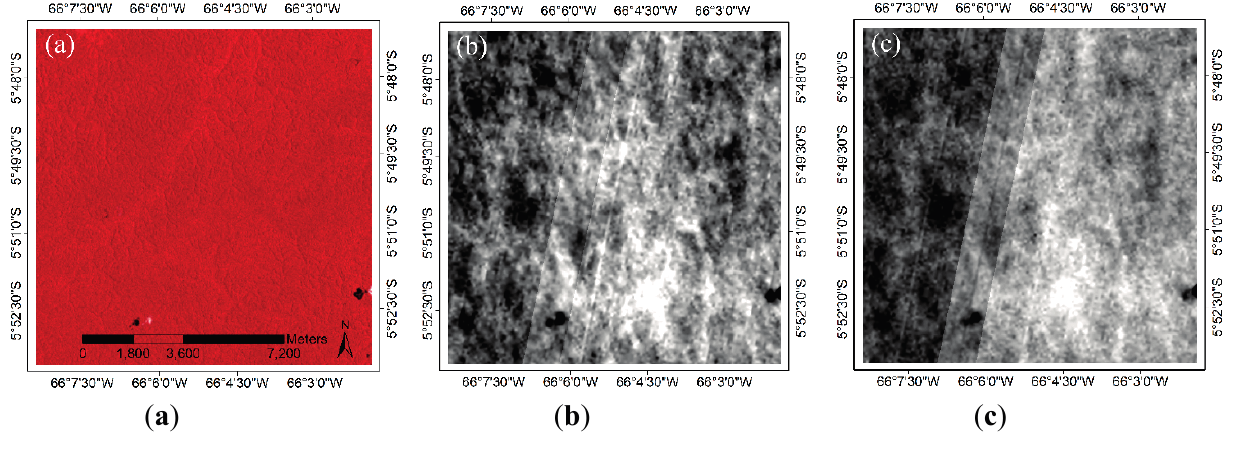
Figure 5. An example of TIRS images with spatial discontinuity. ( a ) False-color image from Operational Land Imager (OLI) near-infrared, red and green bands; ( b ) Band 10 of TIRS; ( c ) Band 11 of